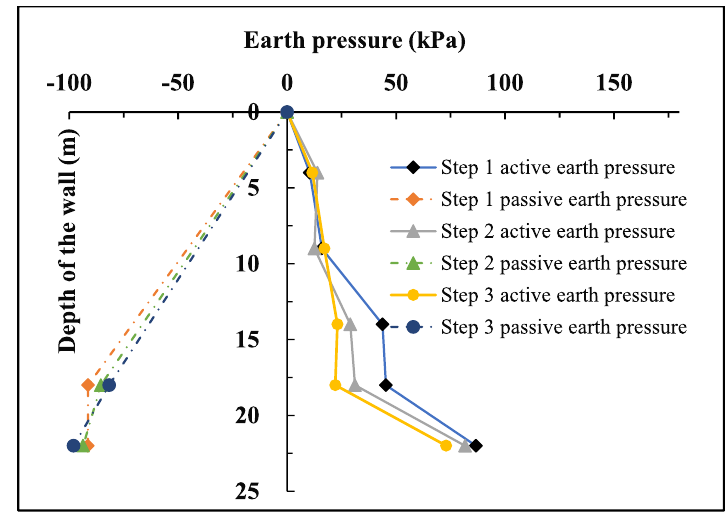
Figure 11. Earth pressure distribution of No. 1 wall from Step 1 to Step 3.